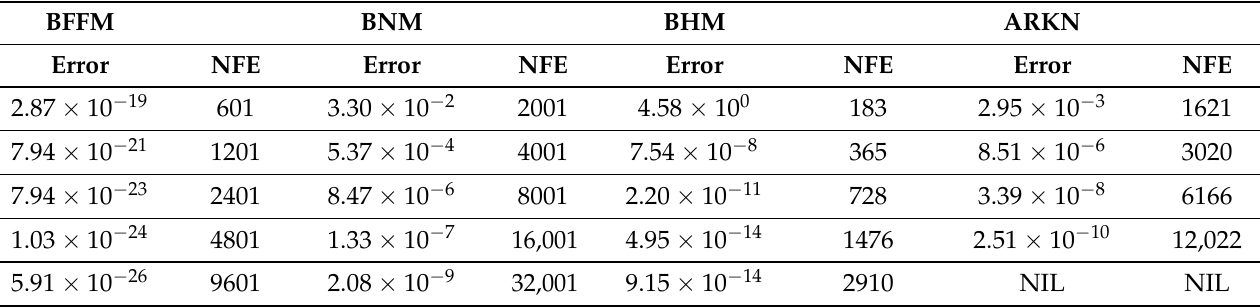
Table 5. Data for Example 5 on the interval [ 0,100 ]